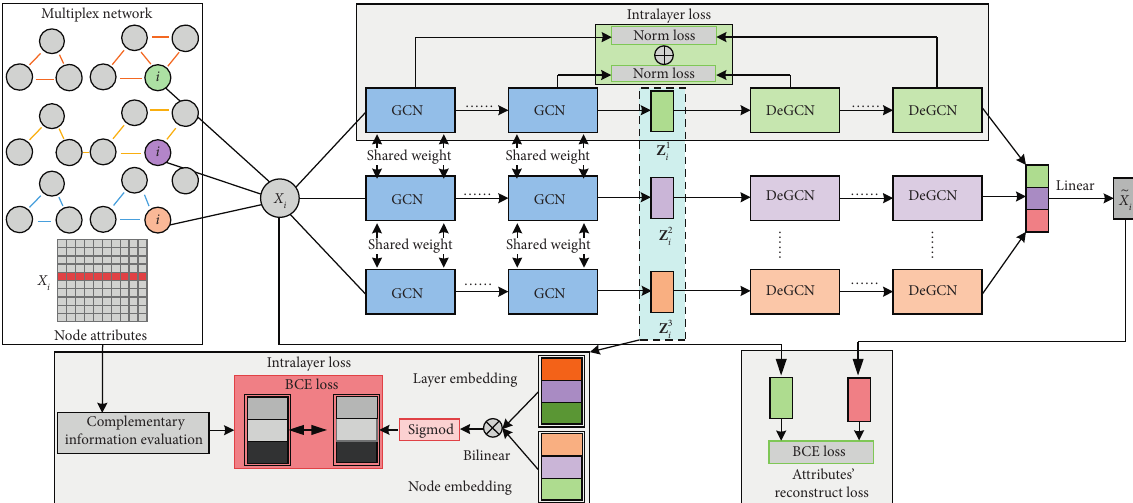
Figure 2: The architecture of HMNE. Our model includes the calculation of three types of loss functions, namely, intralayer embedding loss with shared weight, interlayer embedding loss, and global reconstruction loss. In this figure, GCN is a graph convolution neural layer, and DeGCN is a graph deconvolution neural